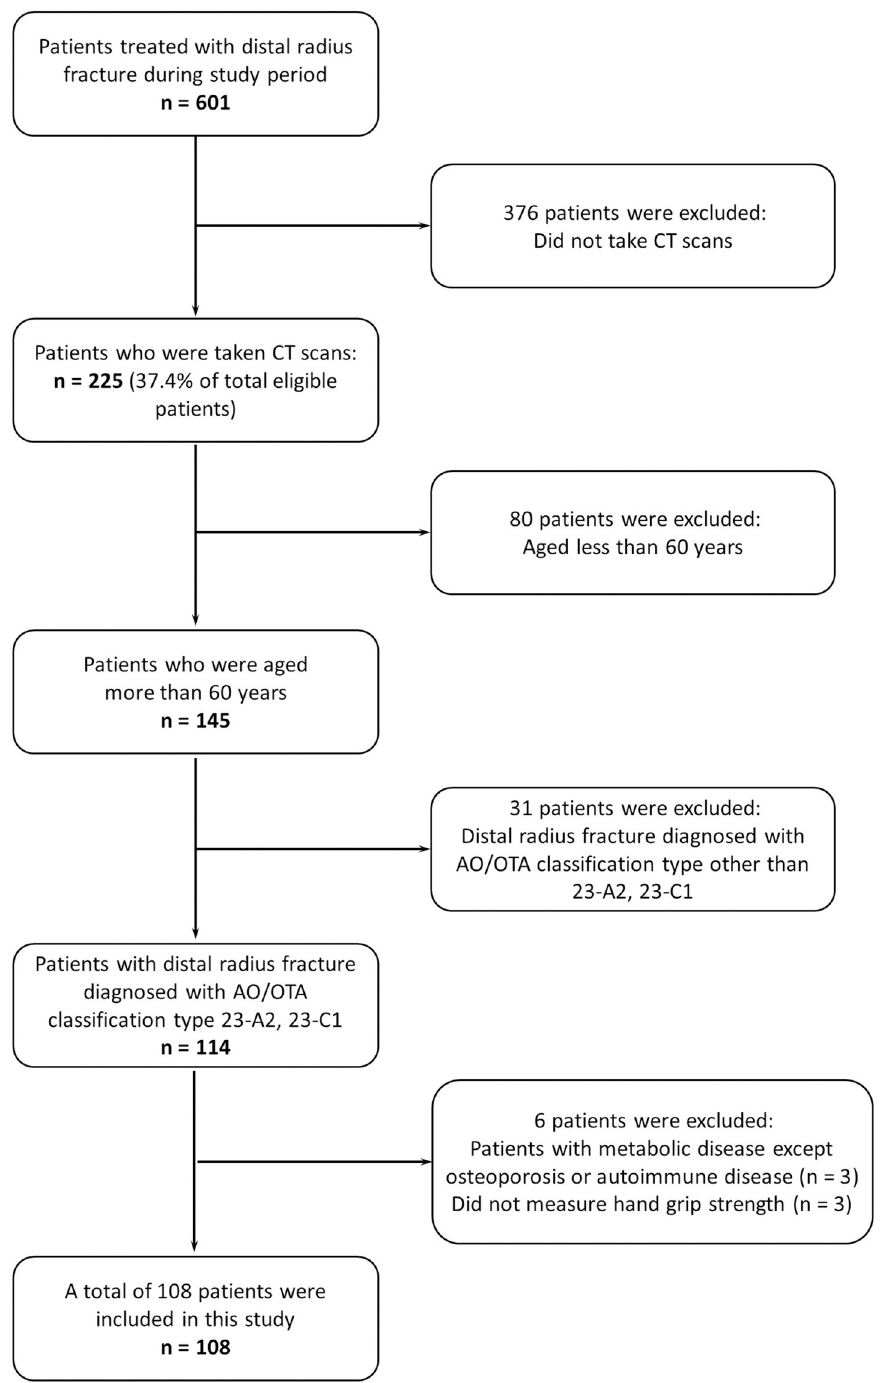
Fig 1. A flow chart of patients included in this